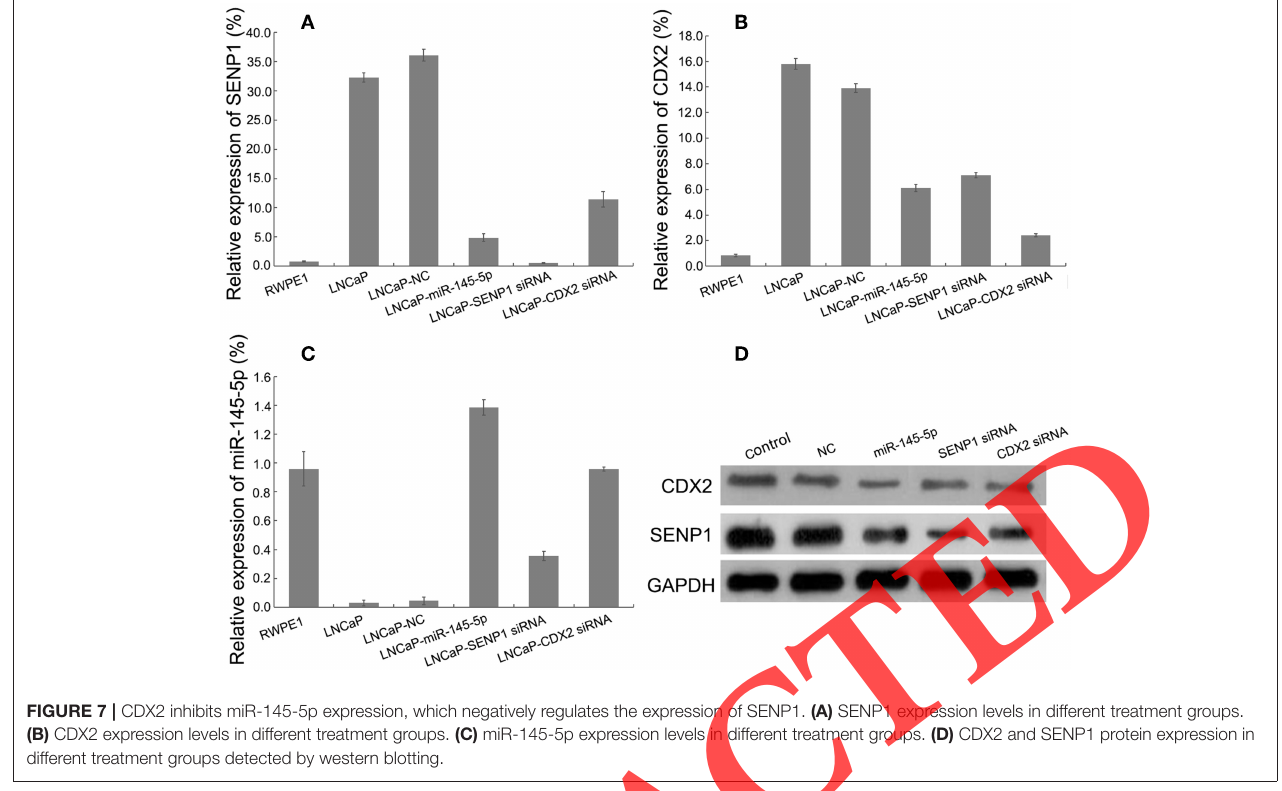
FIGURE 7 | CDX2 inhibits miR-145-5p expression, which negatively regulates the expression of SENP1. (A) SENP1 expression levels in different treatment groups. (B) CDX2 expression levels in different treatment groups. (C) miR-145-5p expression levels in different treatment groups. (D) CDX2 and SENP1 protein expression in different treatment groups detected by western blotting.